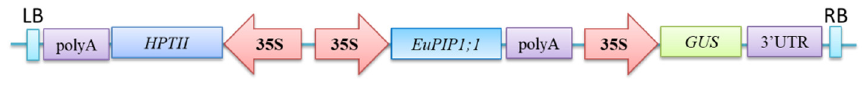
Figure 10. The T-DNA region of pCambia1301-35S-EuPIP1;1